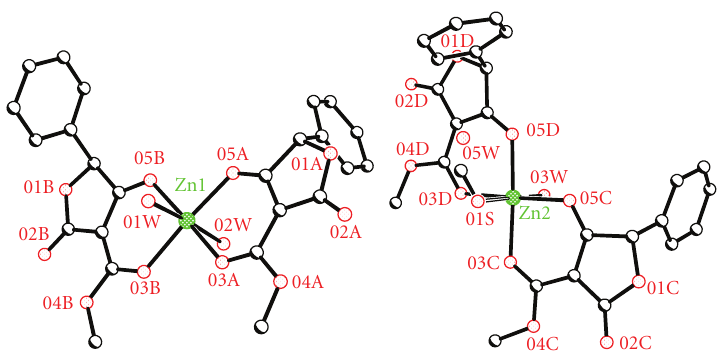
Figure 1: X-ray structure of the two independent complexes in the asymmetric unit of the metal complex, Zn1 and